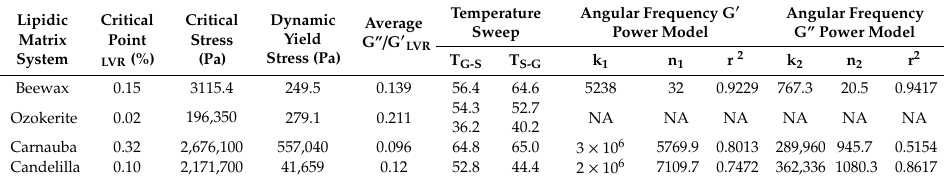
Table 3. Viscoelastic parameters obtained from the oscillation yield strain, frequency and temperature sweep